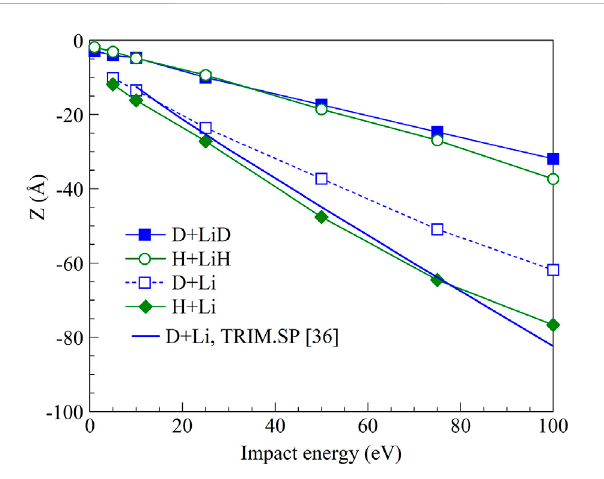
FIGURE 13 Energy dependence of the mean penetration depths of impacting H and D atoms that are incident at 0 o